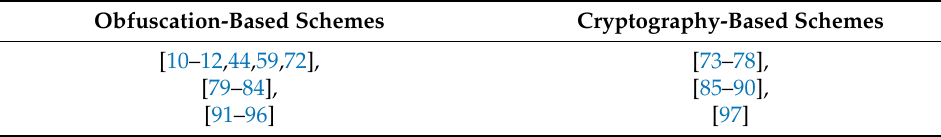
Table 2. Incumbents and CBSDs privacy classification in CBRS.